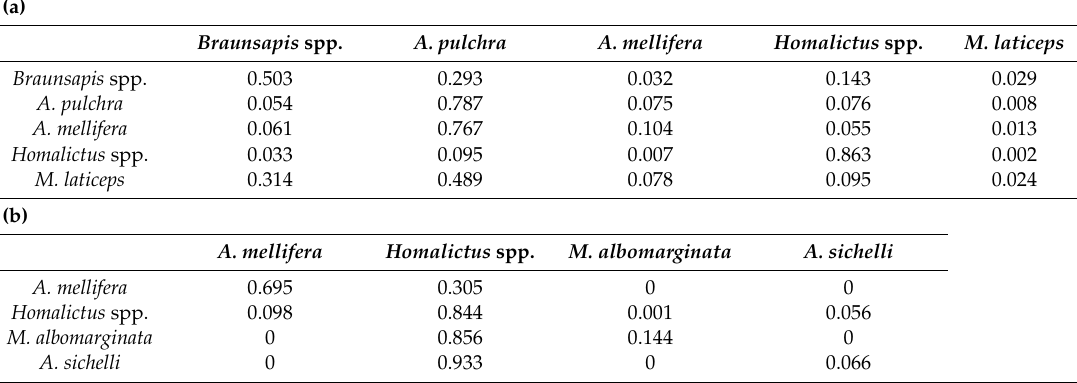
Figure 4. Competition network for the urban context plotted from Müller’s index values. Black circles are proportional to the number of interactions realized by each bee taxon. Solid circles are proportional to the potential for apparent competition at the species level undergone by each bee taxon. Bars connecting the taxa are proportional to the potential for apparent competition exerted by the acting bee taxa on the target bee taxa. Exotic bee taxa are illustrated in red. Table 1. Müller’s index calculated from the plant–pollinator networks for ( a ) the urban context and ( b ) the natural context. Columns and rows correspond to bees exerting potential apparent competition (i.e., acting bees) and bees being the target of potential apparent competition (i.e., target bees), respectively. Therefore the diagonals show apparent intraspecific competition.